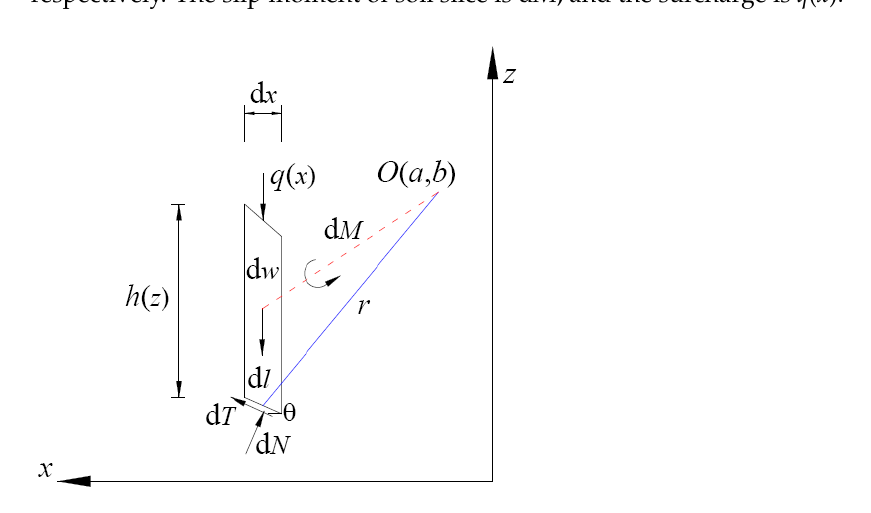
Figure 4. Forces acting on the slices subjected to surcharge when the slice forces are neglected.